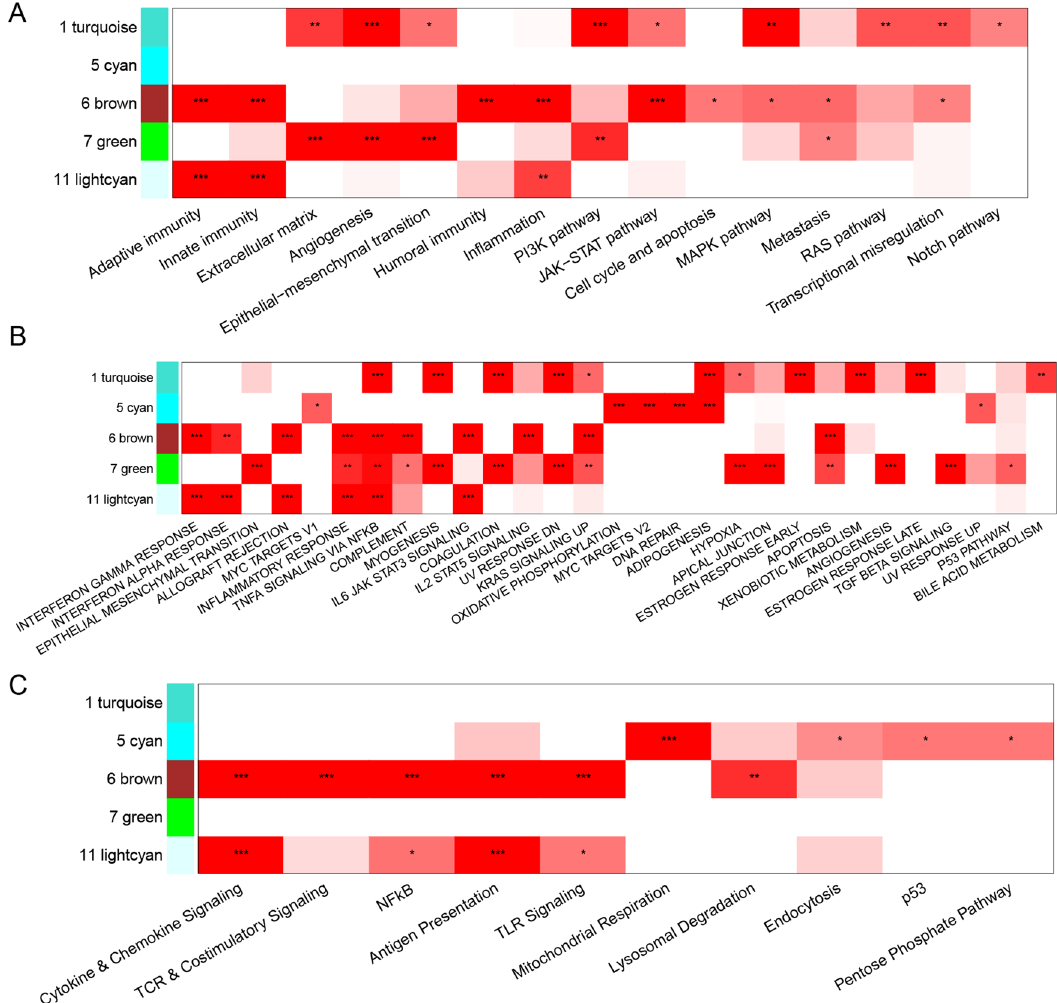
Fig. 4 Pathways signi fi cantly enriched in the co-expression modules that were associated with African American (AA) (modules 6 and 11) or (Non-African American (NonAA) modules 1,5, 7) cancers. A Nanostring cancer hallmarks, B MSigDB Hallmarks, and C Nanostring metabolism (* p < 0.05, ** p < 0.01, *** p < 0.001; Permutation